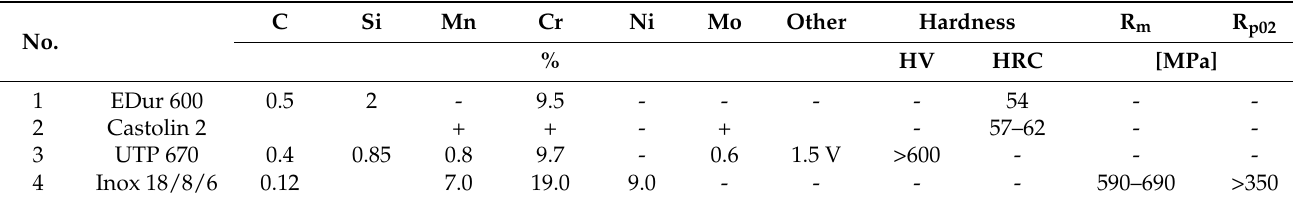
Table 4. Chemical composition and mechanical properties of the applied filler